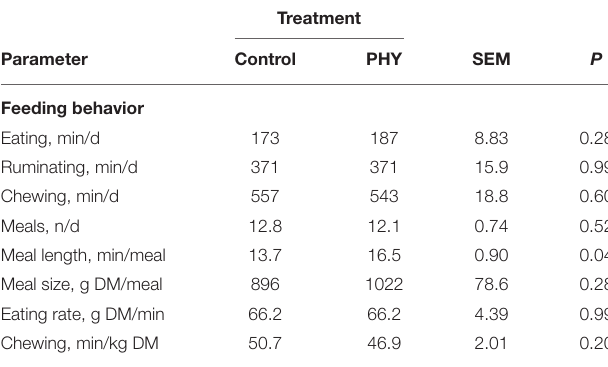
TABLE 5 | Comparison of feeding behavior over 48h of crossbred finishing bulls measured at mid-point of finishing period.